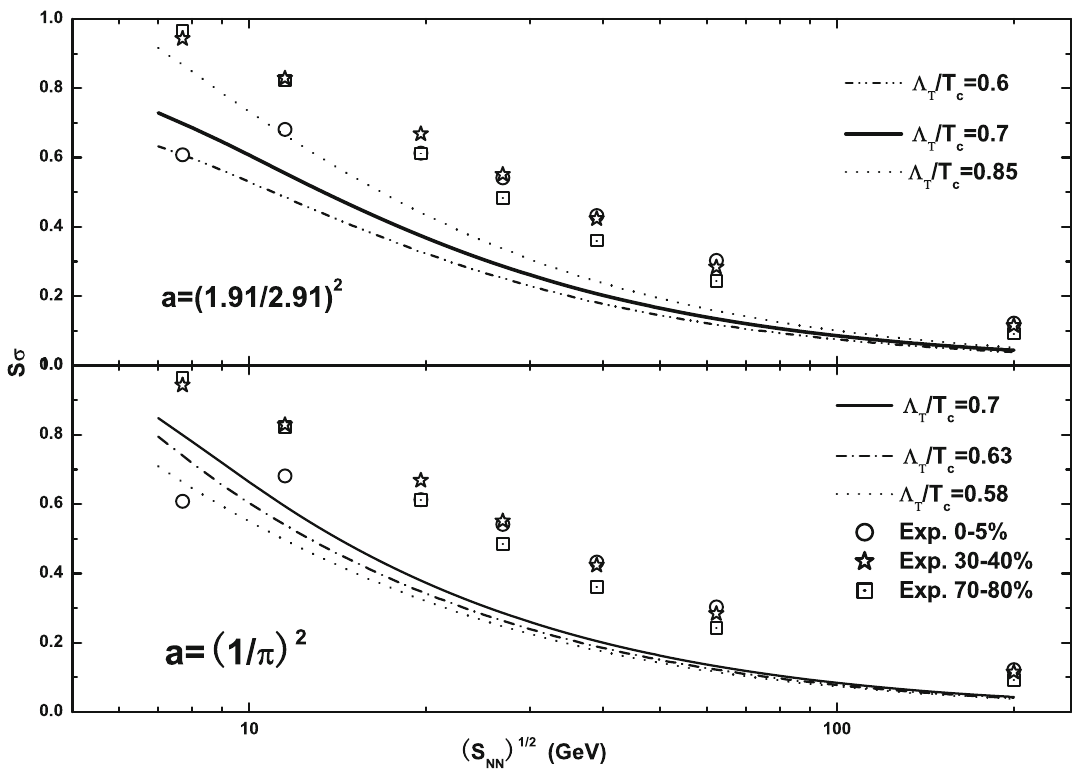
√ S NN for (cid:10) T / T c = 0 . 85 , 0 . 7 , 0 . 6 at a = ( 1 . 91 / 2 . 91 ) 2 . The bottom